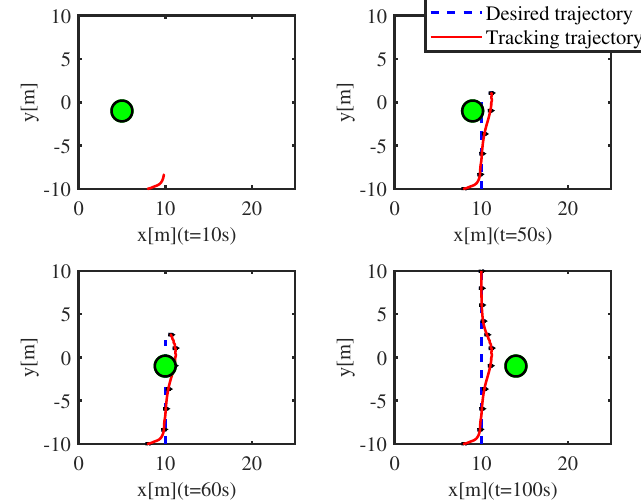
Figure 8. Four moments of trajectory tracking control.